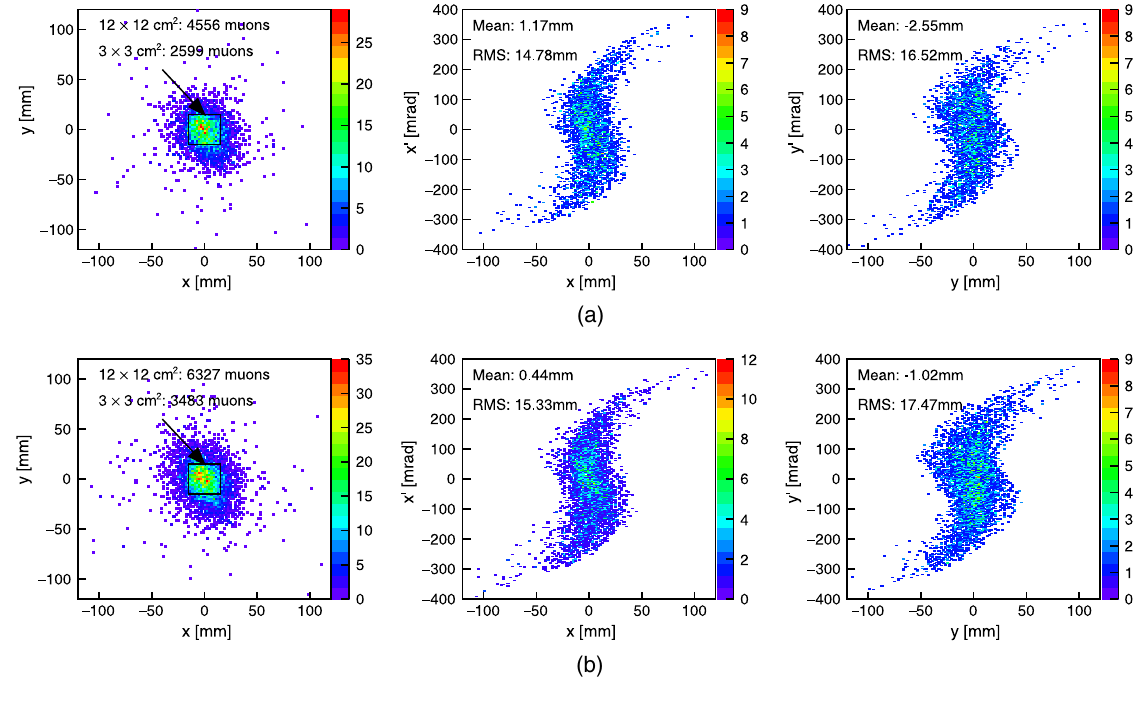
FIG. 24. The beam spots for the Super- μ E 4 beamline: (a) with OTE; (b) with NTE.